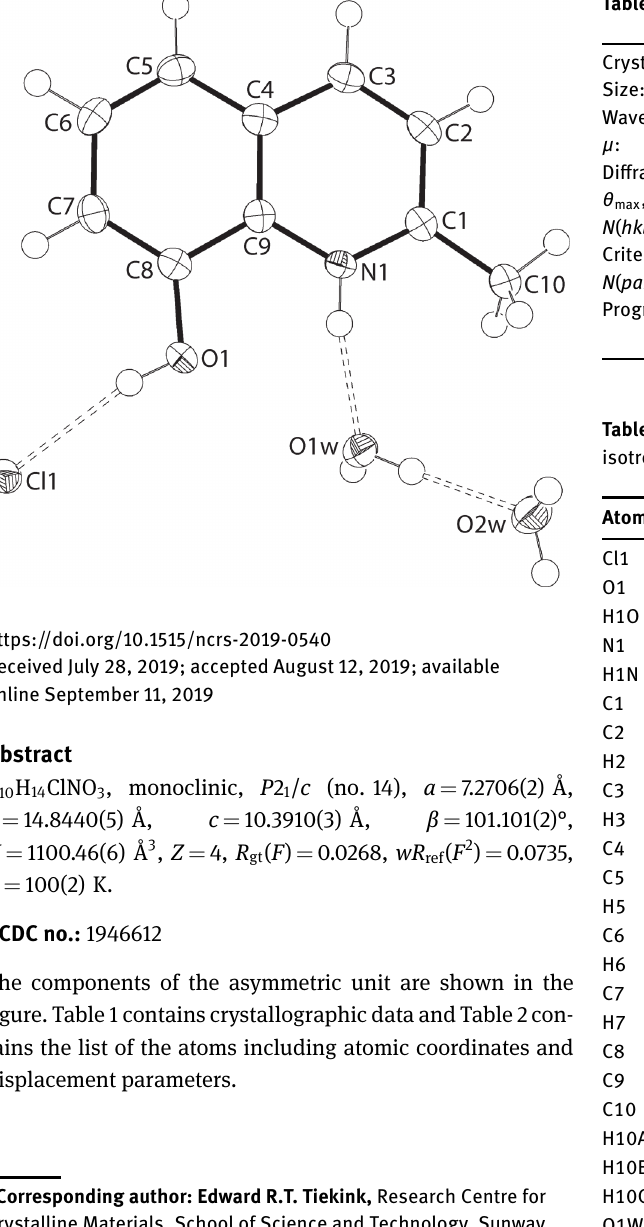
Table 1: Data collection and handling.